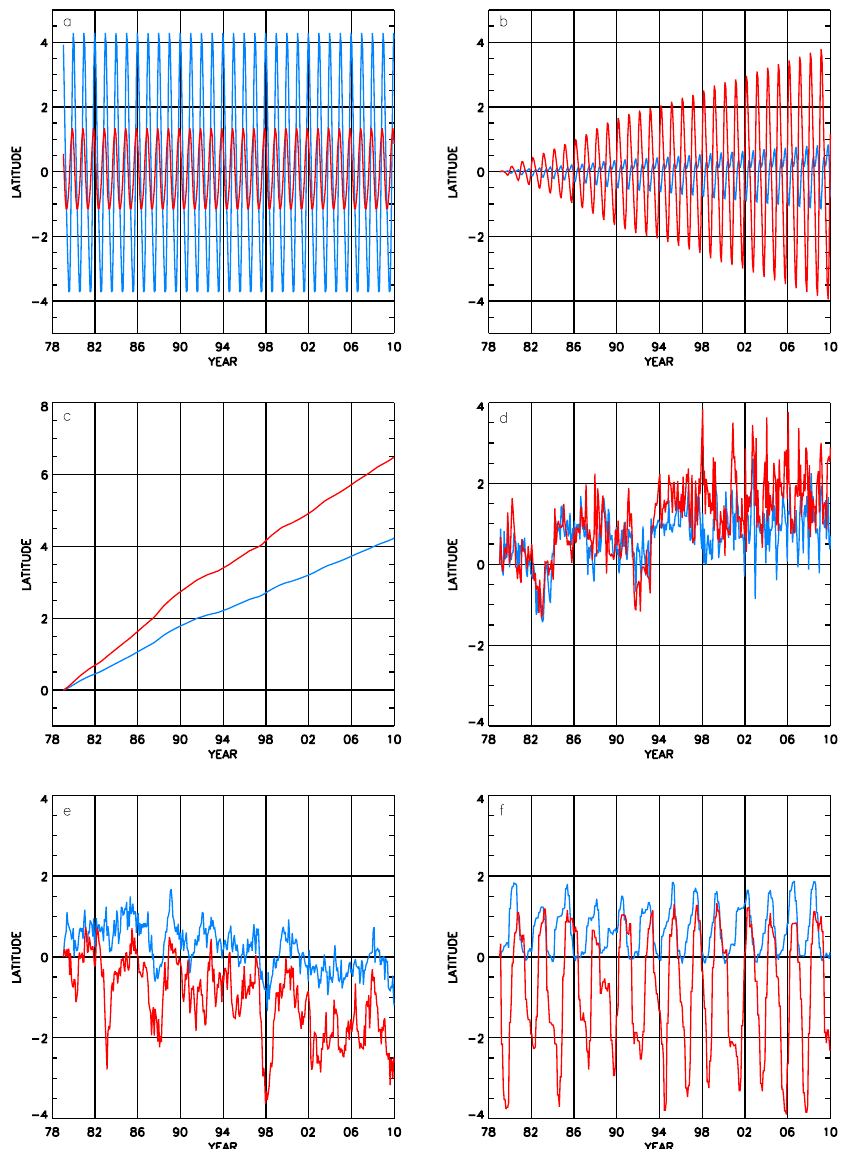
Fig. 7. Contribution of each climate index to the monthly mean equivalent latitude. The red lines are the results for the Southern Hemisphere, the blue for the Northern Hemisphere: (a) results for those seasonal terms with an amplitude independent of time, (b) results for those seasonal terms with a time dependent amplitude, (c) results for the RADF index, (d) results for the TEMP index, (e) results for the ERSST index, (f) results for the QBO